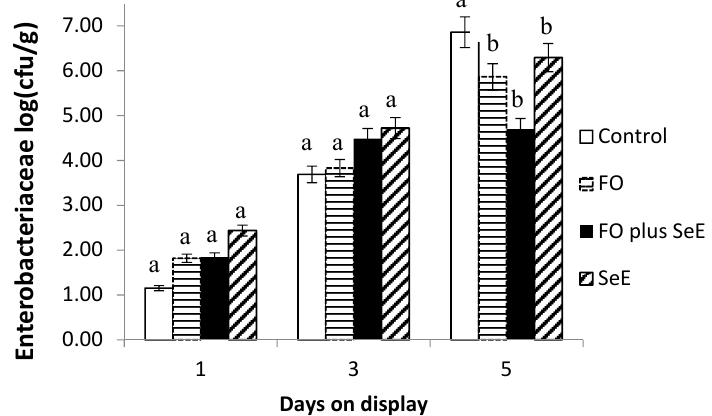
Figure 3. Mean log counts of bacteria of the family Enterobacteriaceae obtained for the di ff erent treatments according to days on display; a, b—treatments in the same time point, followed by di ff erent lowercase letters, di ff er significantly at the 5% level.